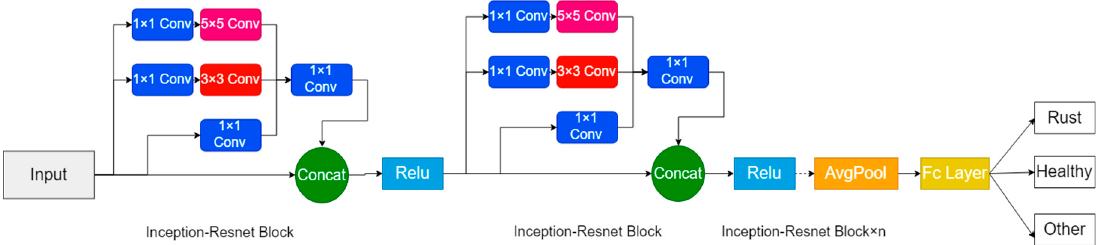
Figure 4. Schematic of the architecture of the proposed DCNN model for yellow rust detection.